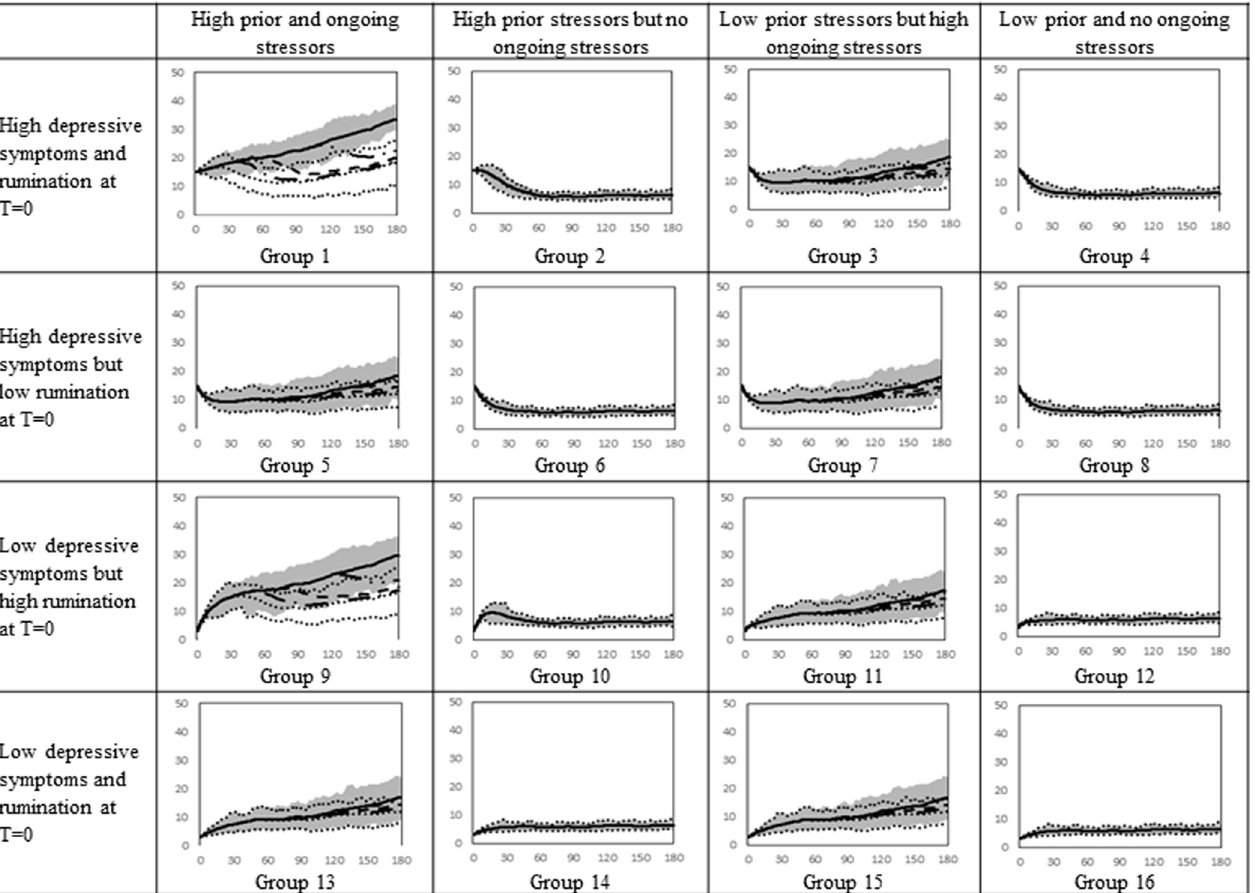
Fig 7. Simulated depressive symptoms for 16 male groups who receive therapy 6 months, 2 years, 4 years, and 8 years after their first episode. Solid line captures the baseline, the dot line, long-dash-dot, dashed line, and long-dash-dot-dot depict the depressive symptoms when boys receive therapy 6 months, 2, 4, and 8 years after their first